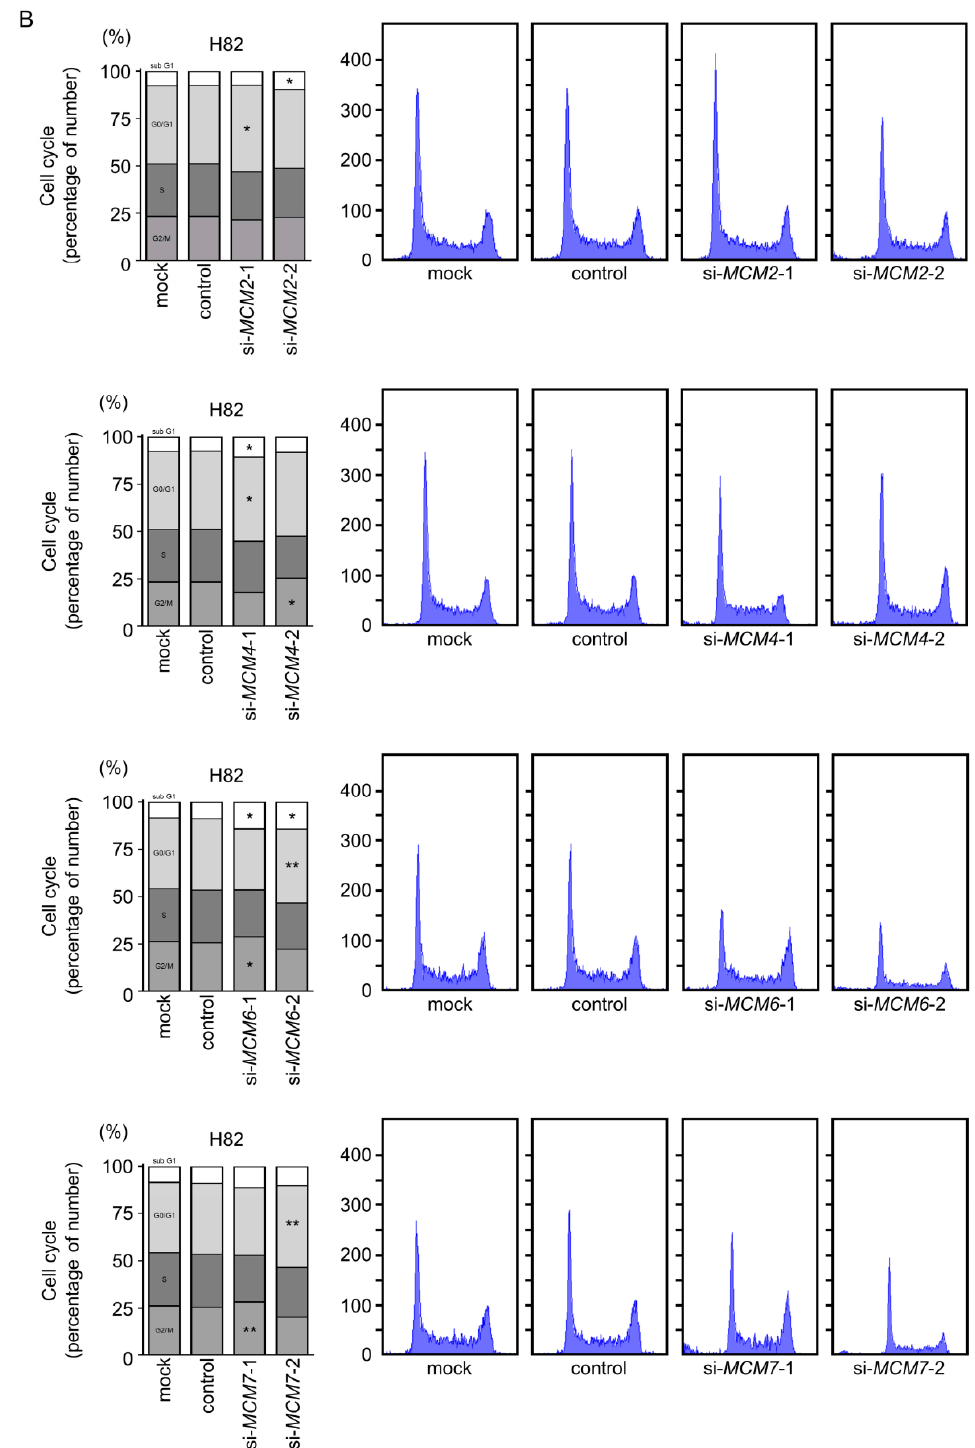
Figure 5. Effect of siRNA-mediated knockdown of MCM family members on cell cycle regulation in SCLC cells. ( A ) In SBC-3 cells, the cell cycle assay indicated G0/G1 phase arrest in cells transfected with siRNAs targeting MCM2 or MCM4 and G2/M phase arrest in cells transfected with siRNAs targeting MCM6 and MCM7 . ( B ) In H82 cells, si- MCM2 -1 or si- MCM4 -1 transfected cells increased proportion of cells in the G0/G1 phase and si- MCM6 -1 or si- MCM7 -1 transfected cells increased proportion of cells in the G2/M phase. Also, the number of cells in the G0/G1 phase were significantly elevated in si- MCM6 -2 and si- MCM7 -2 transfected cells compared with control cells. *, p < 0.0001, **, p <